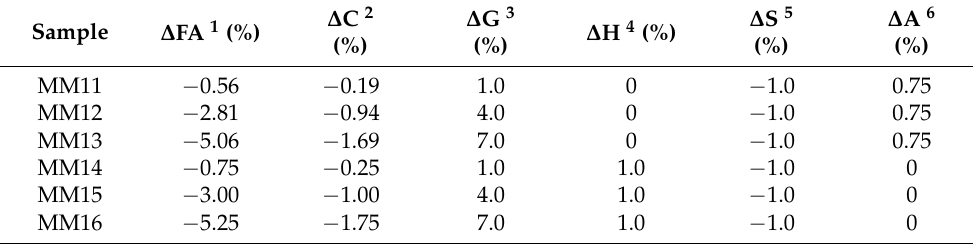
Table 7. Variation in the relative weight of the components of the mortars in relation to the refer- ence sample.